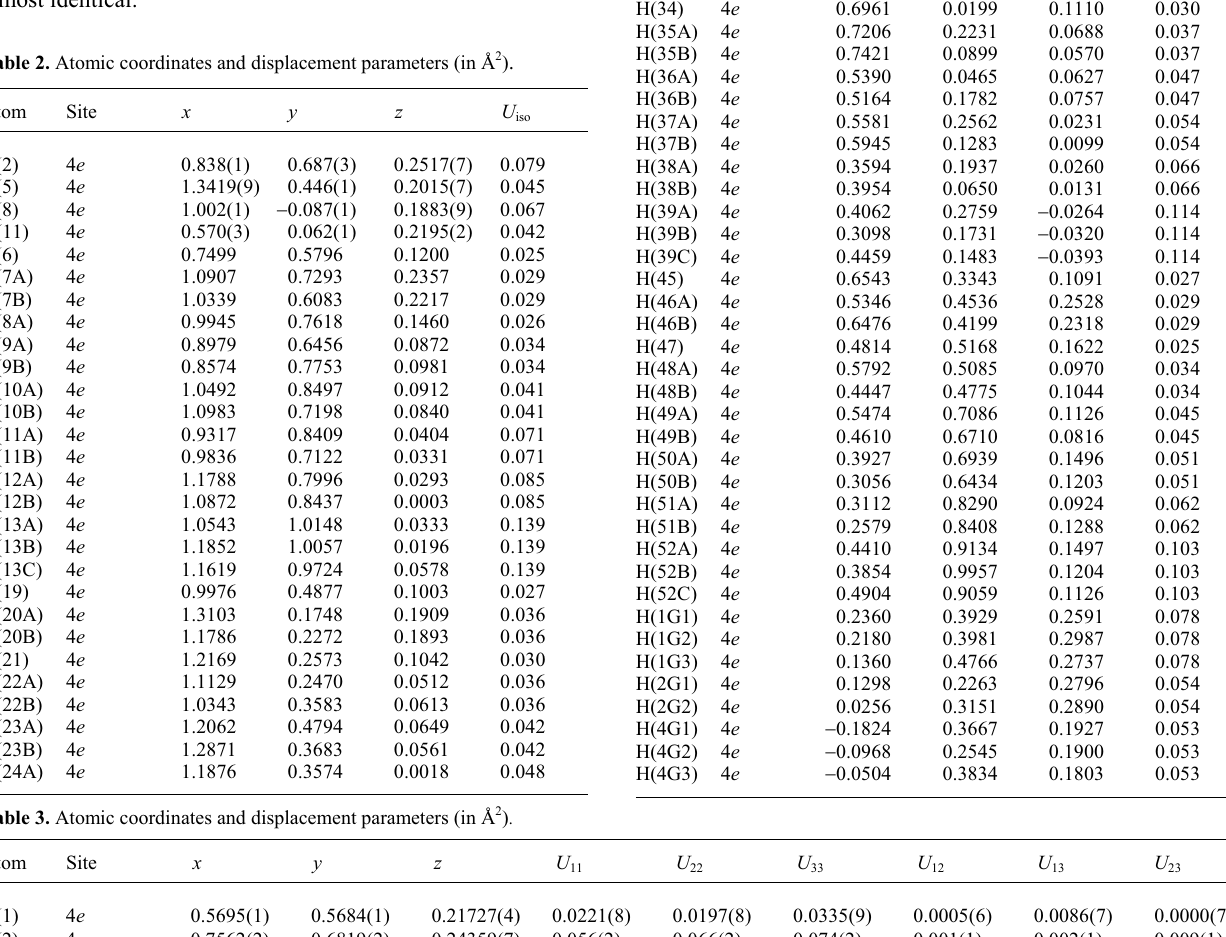
Table 2. Atomic coordinates and displacement parameters (in Å 2 ) .